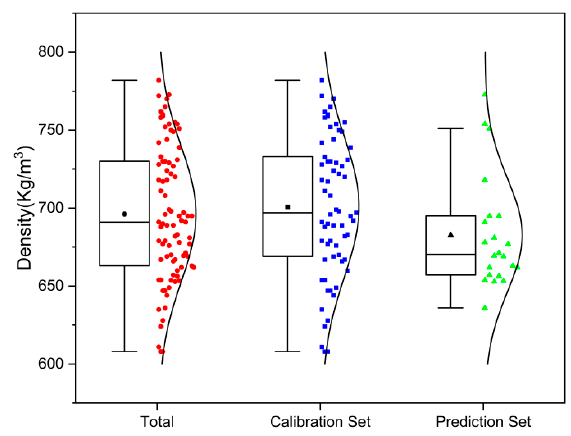
Figure 2. The boxplot of wood density of Chinese white poplar.